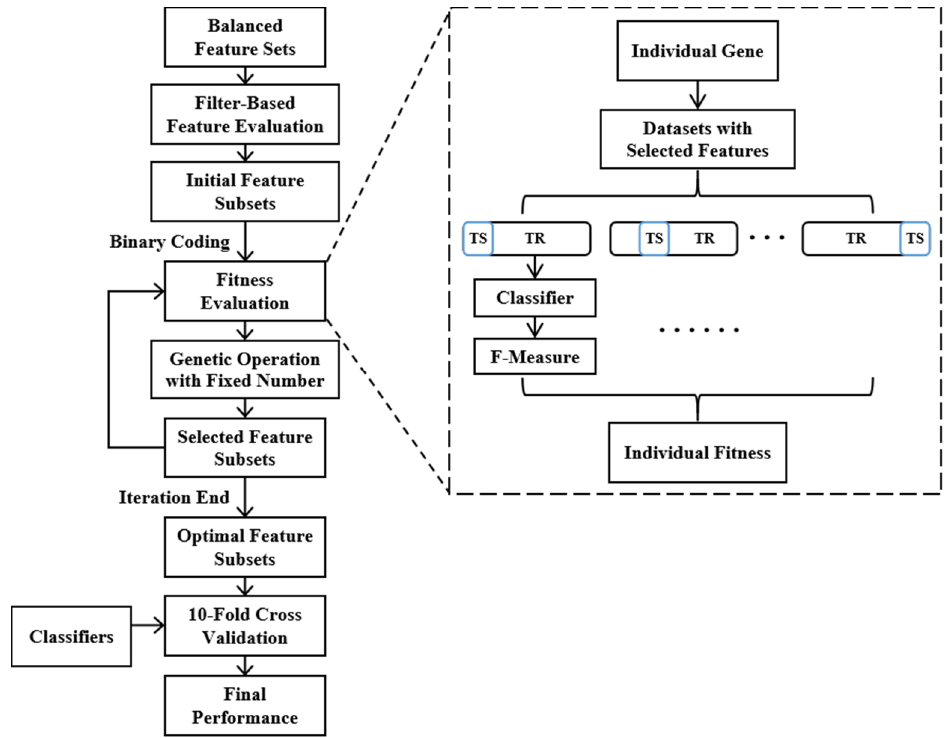
Figure 4. Block diagram of the two-stage genetic-based feature selection method.